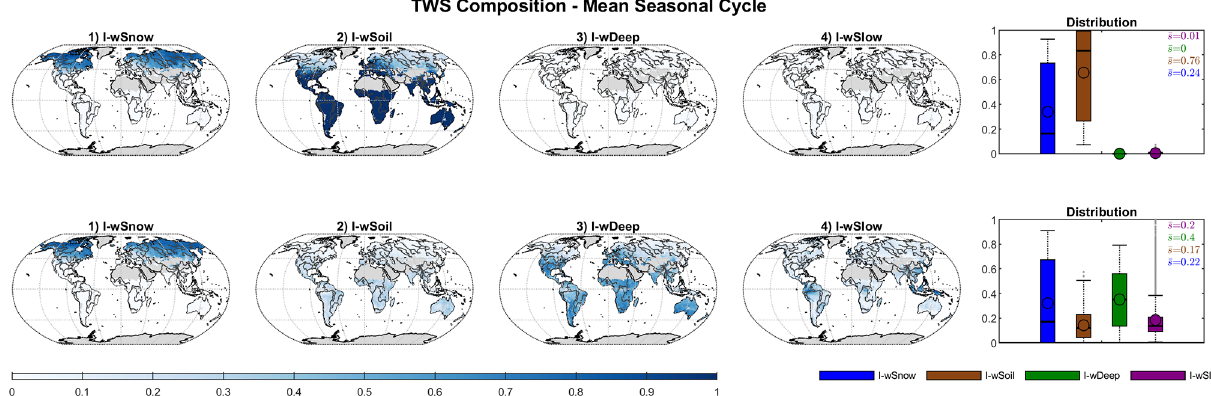
Figure 5. Global distribution of the impact index I for the contribution of simulated snow (wSnow), soil (wSoil), deep water storage (wDeep), and delayed water storage (wSlow) to the mean seasonal cycle of total water storage, for B and VEG.